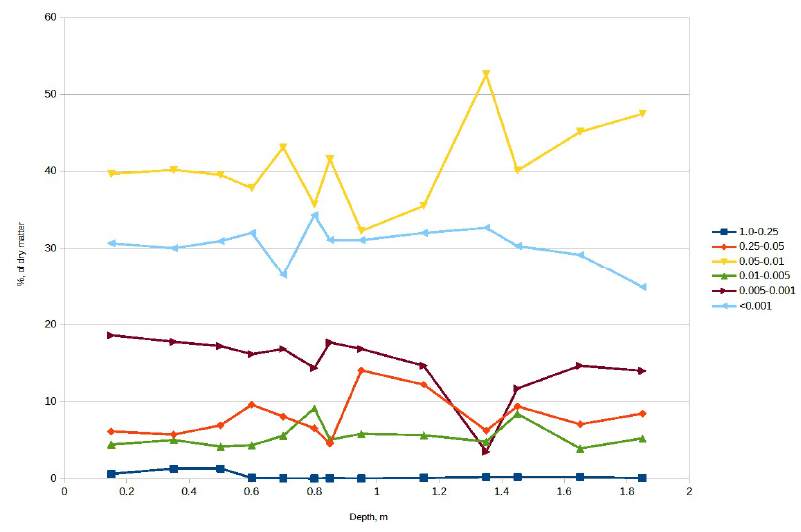
Figure 7. Granulometry of soils in the section 1 of Mohylna 3. Analysis by O.O. Halahan. Legend: sizes of particles in mm. Elaboration—DK.